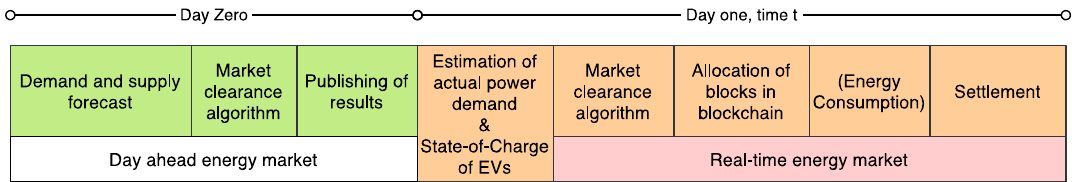
Figure 10. Example of processing a Day-ahead energy market and Real-time energy market.